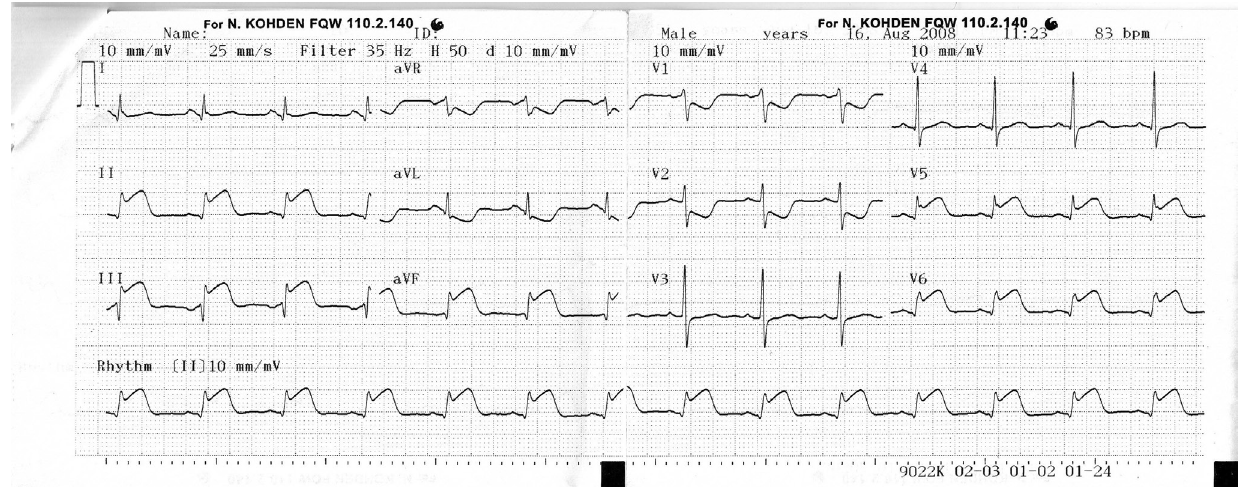
Figure 1 - Electrocardiogram (ECG) showing D2-D3-aVF-V5 and V6 ST- segment elevation.